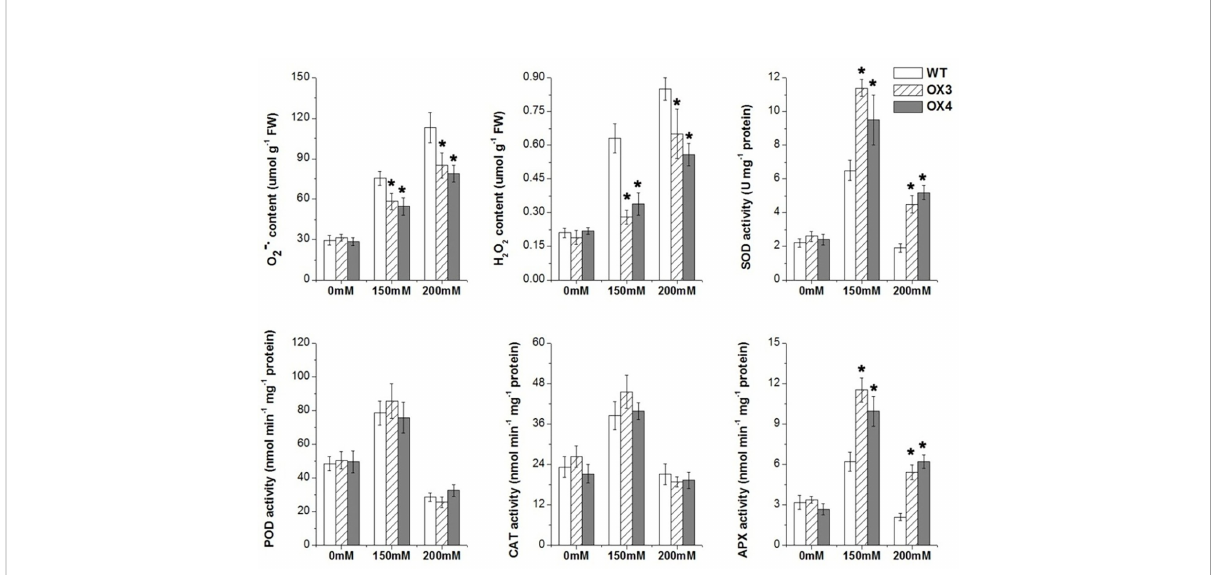
FIGURE 7 Reactive oxygen species contents and antioxidant enzyme activities of ZmGnTL transgenic Arabidopsis. ZmGnTL -OX plants and WT were treated with 0 mM, 150 mM, and 200 mM NaCl for 10 days. Data are shown as means ± SE of three to fi ve biological replicates, and * indicated statistical signi fi cance at *P<